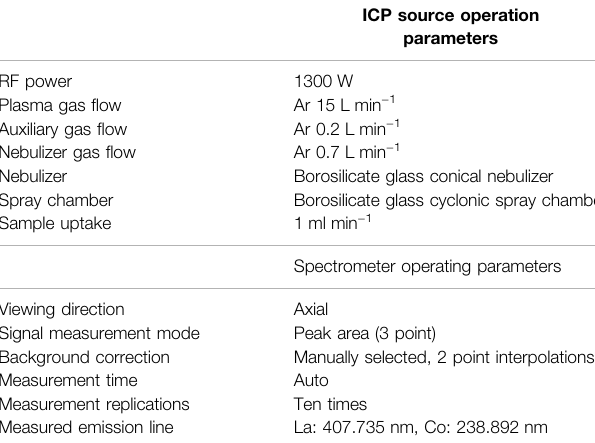
TABLE 2 | Instrumental conditions of PerkinElmer Optima 4300DV